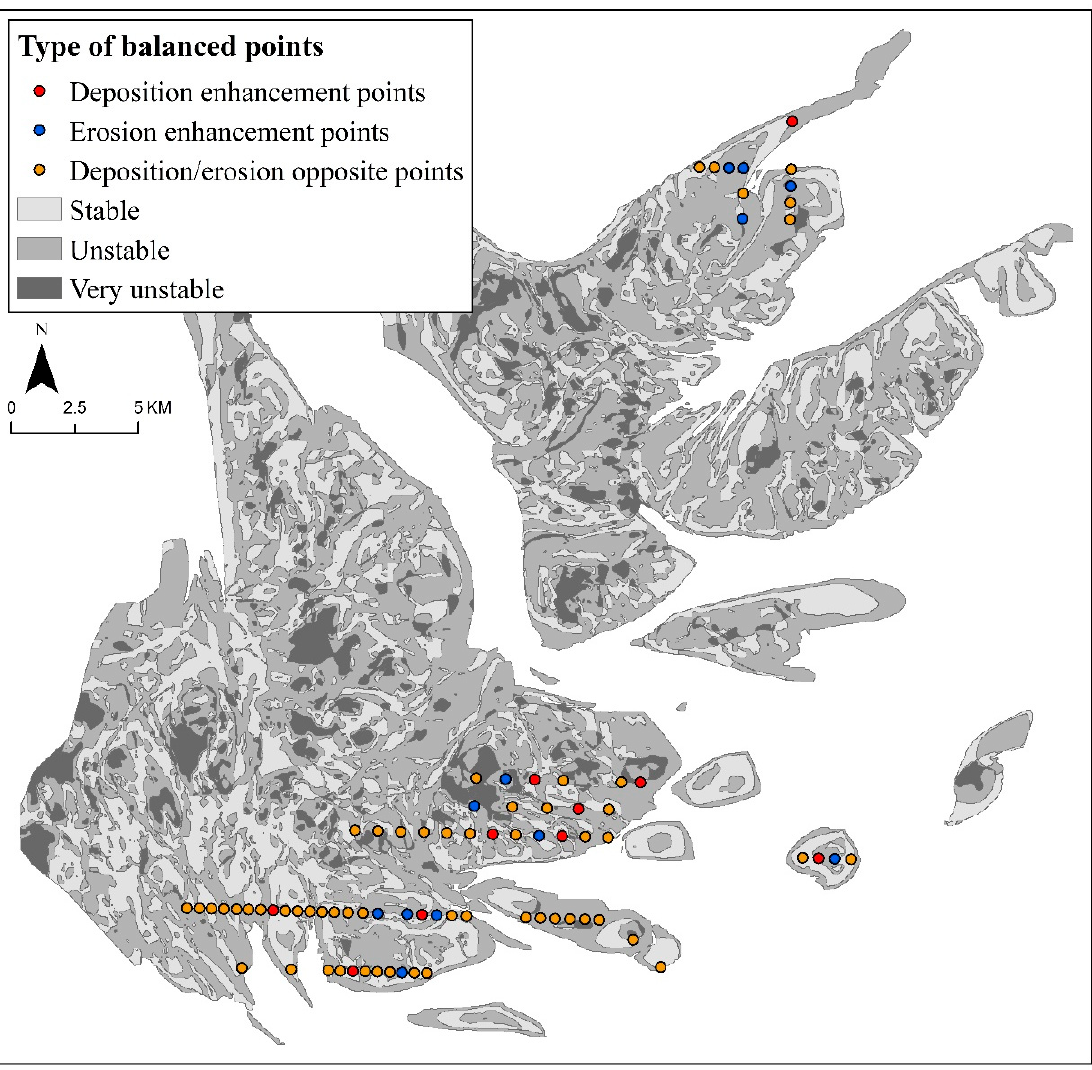
Figure 6. Classification results for the impact of persistent siltation at the balance points (the differ- ently coloured points represent the types of balanced points; the colour of the study area represents the stability of the topography).